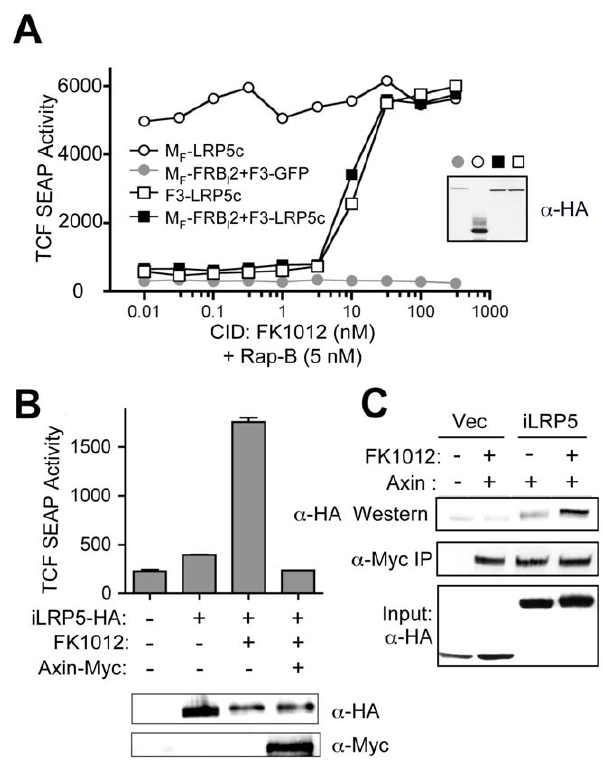
Figure 2. Axin is a critical downstream regulator of iLRP5 and interacts with iLRP5. ( A ) Effects of dimerization and membrane translocation of LRP5c on Wnt/ b -catenin signaling. Activation of the TCF N reporter in 293 cells transiently transfected with 1 m g each TCF-SEAP ), F3-LRP5c ( % ) or M F - reporter and M F -LRP5c ( # ), M F -FRB l 2 + F3-GFP ( FRB l 2 + F3-LRP5c ( & ) expression plasmids is shown. After 24 hours, cell aliquots were treated with CID and suboptimal (5 nM) Rap-B, and SEAP activity was measured after 24 hours. ( B ) Effect of Axin on iLRP5- mediated b -catenin activation. 293 cells were transiently transfected with 1 m g each of TCF-SEAP and iLRP5 plasmids with our without myc- tagged Axin. After 24 hours, cells were treated with 100 nM CID (AP20187) or diluent alone, and SEAP activity was measured after an additional 24 hours. Protein expression levels were determined by anti- myc and anti-HA blotting (inset). ( C ) Dimerization-dependent interac- tion of Axin and iLRP5. 293 cells were transfected with 1 m g of indicated combinations of iLRP5 and Axin. After treatment with 100 nM homodimer (AP20187) for 24 hours (lane 2, 4), whole cell lysates were immunoprecipitated with anti-myc antibody (myc). Co-immunoprecip- itation of LRP5c was analyzed by anti-HA blot (HA). Backbone (F v 9 -F vls - HA) or iLRP5 (F v 9 -F vls -iLRP5-HA) protein expression was detected by anti-HA blot (Input: HA). All data are representative of at least two (panel A) or three (panels B–C) independent experiments with similar results. Error bars (B) represent S.D. of triplicate